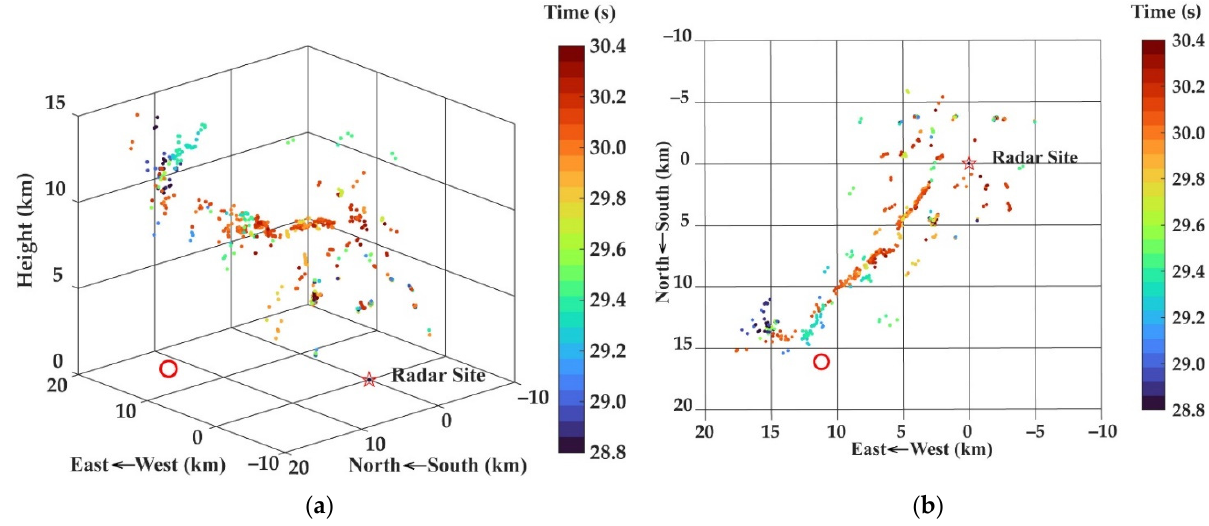
Figure 9. The 3D reconstruction and 2D project of the lightning channel. ( a ) The 3D locating result of the lightning channel, VLF locating result (shown as two red circles), and the radar site (marked as a pentagram); ( b ) the projection of the 3D locating result at the top view.